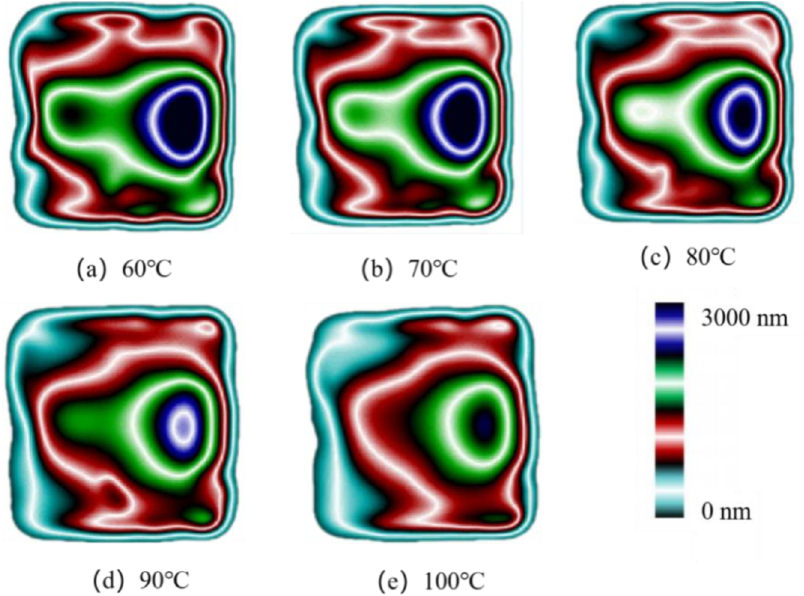
Figure 4. Birefringence distributions at different mold temperatures.